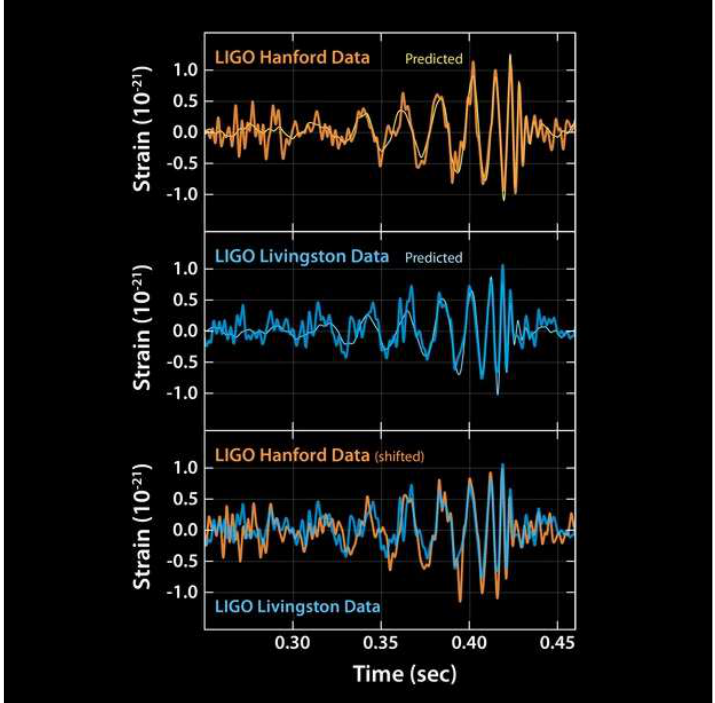
Figure 4. The gravitational waveforms in this figure correspond to the first detection event GW150914. The gravitational wave strain is plotted against time. The top two panels show the detector output from the LIGO Hanford and LIGO Livingston. The waveforms predicted from general relativity are superimposed on the detector output. The bottom panel shows the detector output from the LIGO Livingston detector along with that from LIGO Hanford detector shifted appropriately taking into account the time lag in the arrival of signal and the difference in the detector orientations. They